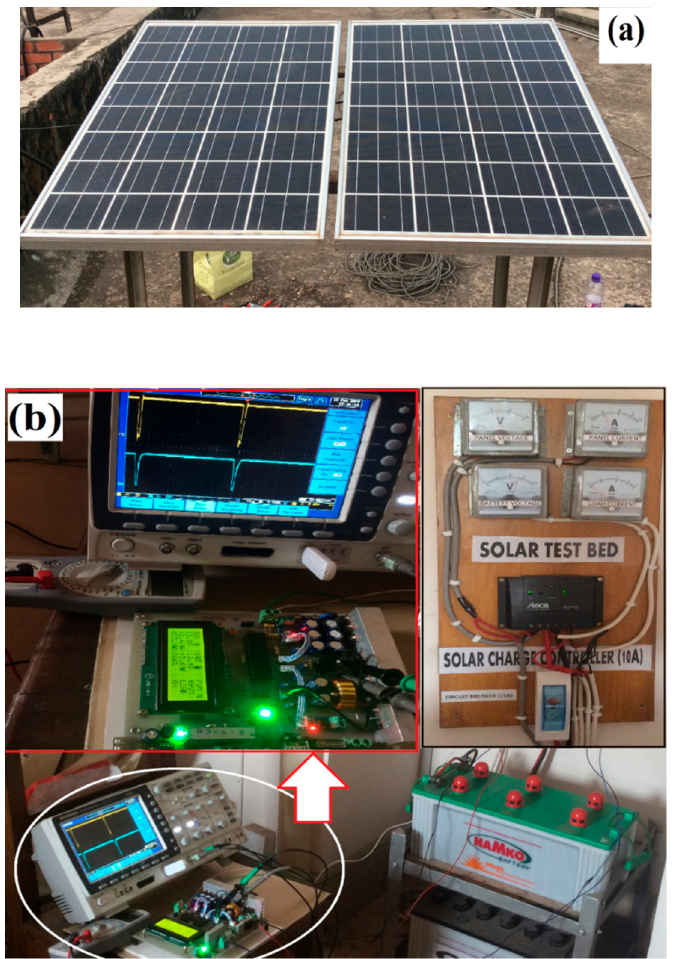
Figure 11. Experimental setup of the complete system: ( a ) PV module on the rooftop, and ( b ) laboratory setup (inset) with battery (bottom-right corner) and metering board (top-right corner).